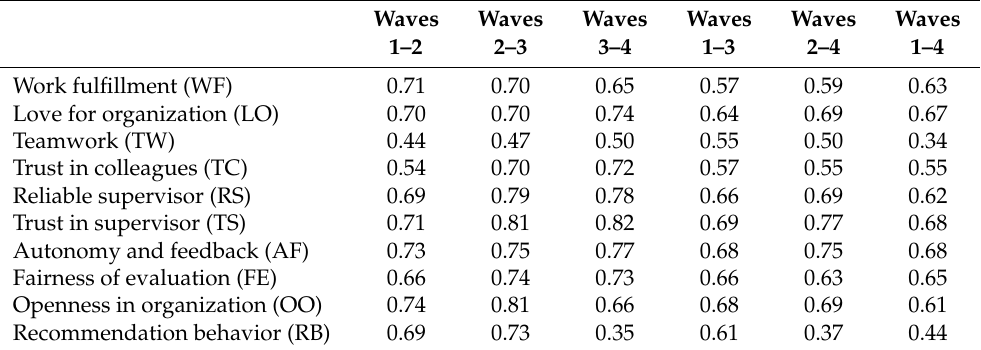
Table A2. Test–retest reliability of the Organizational Engagement Questionnaire ( n = 96 in a technol- ogy company in